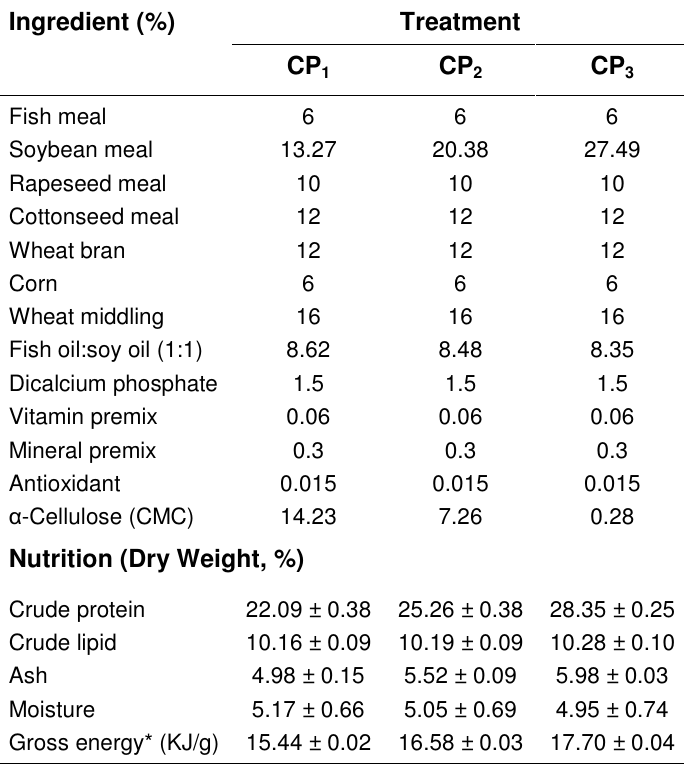
Treatment Ingredient